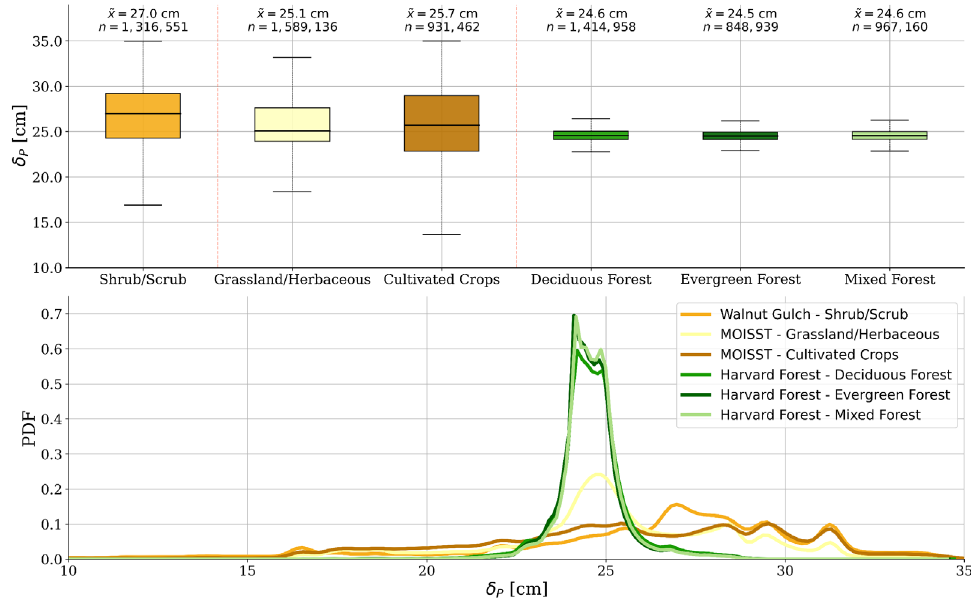
Figure 9. Boxplots and probability density functions (PDFs) of estimated permittivity-based penetration depths δ P for main land cover classes at the AirMOSS monitoring sites Walnut Gulch, MOISST, and Harvard Forest. The results are displayed for all acquisition dates (Figure 1, Section 2). (cid:101) x represents the respective median value, n is the total amount of values per boxplot.